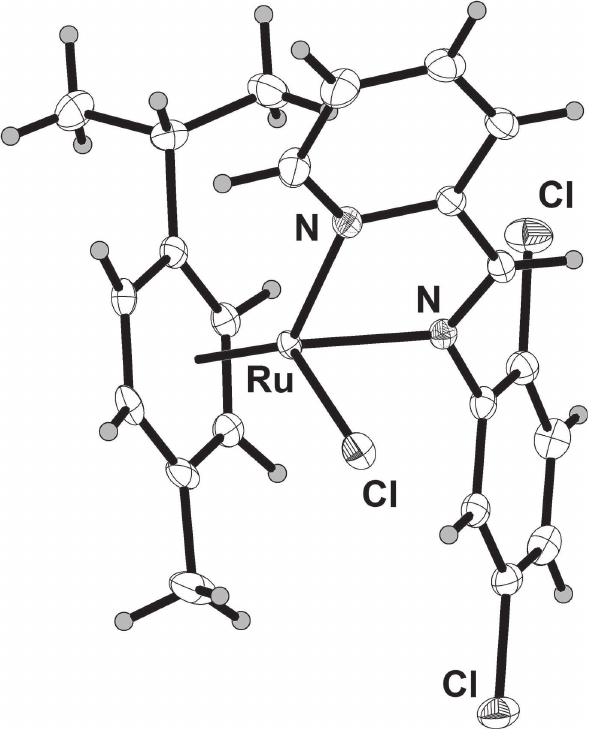
Table 1: Data collection and